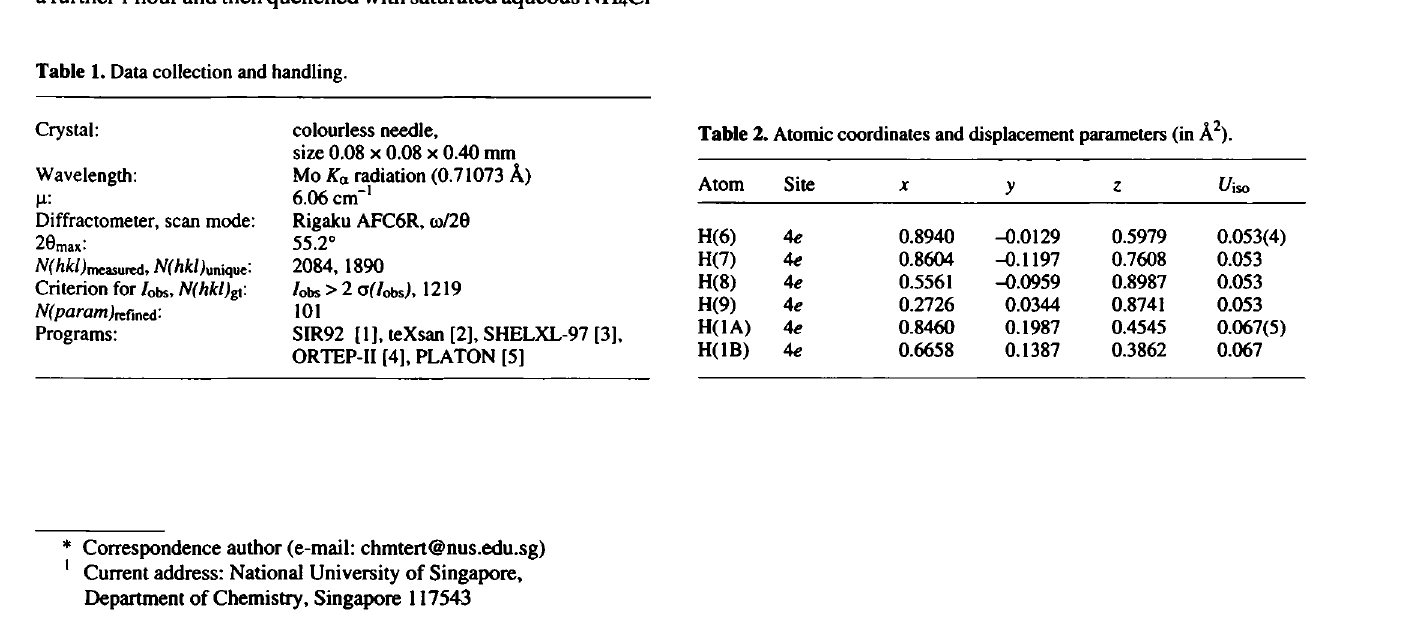
Table 1. Data collection and handling.